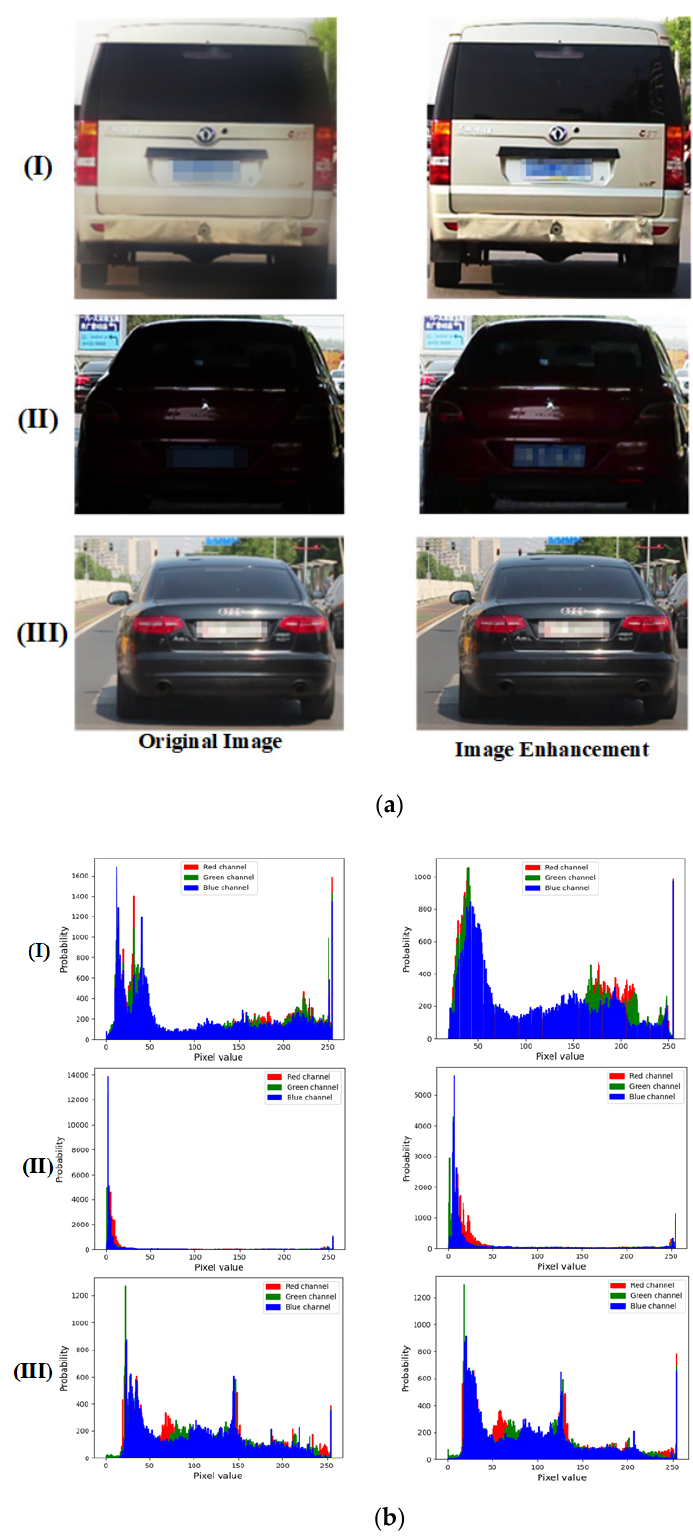
Figure 3. Image enhancement in typical scenarios [38]. ( a ) shows the comparison before and after image enhancement in normal lighting conditions, dark lighting conditions and strong lighting conditions, respectively; ( b ) shows the comparison before and after image RGB histogram enhancement in normal lighting conditions, dark lighting conditions, and strong lighting conditions, respectively. (I) is images under normal lighting conditions; (II) is images under dark lighting conditions; (III) is images under strong lighting conditions.